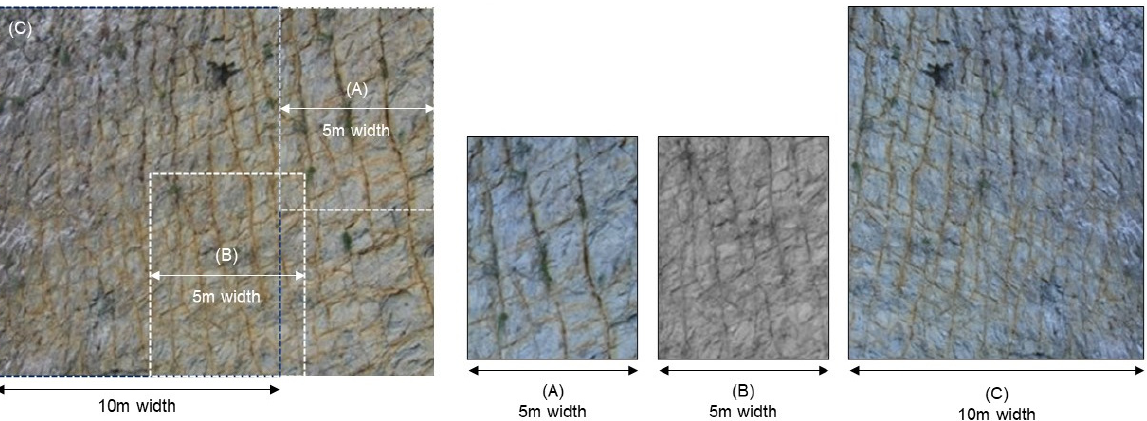
Figure 9. Outcrop used as part of the survey described in the text to analyse the subjectivity of the processes by which different persons would determine GSI.